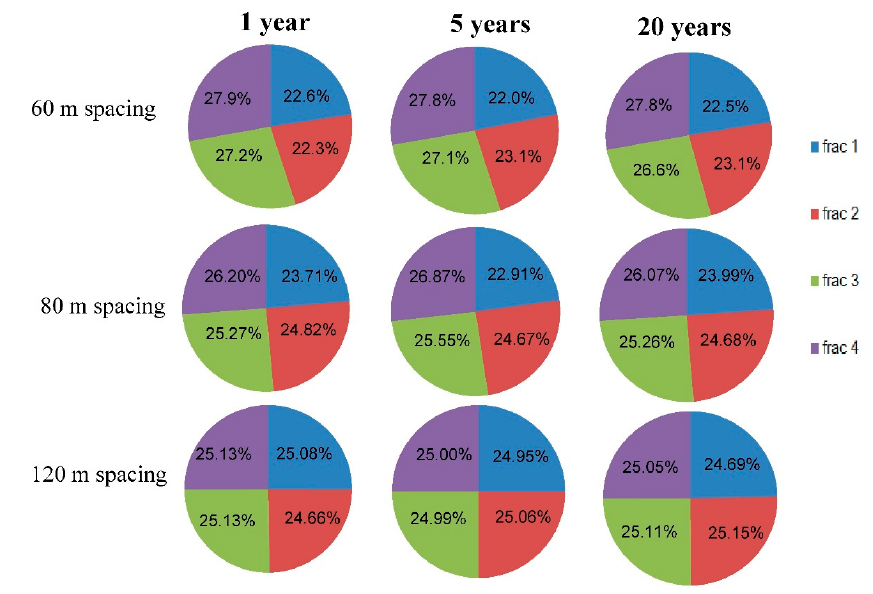
Figure 9. Net energy contribution (%) through each fracture after 1, 5, and 20 years of production with 60, 80, and 120 m fracture spacing.